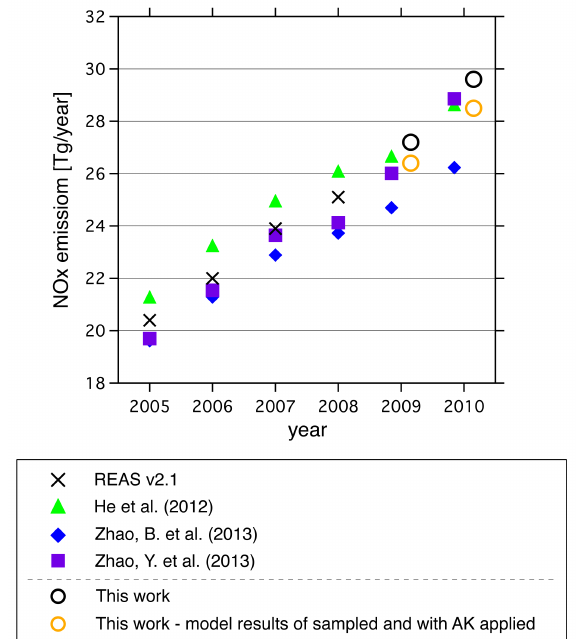
Fig. 7. Comparison of estimated NO x emissions from China in this work and in other